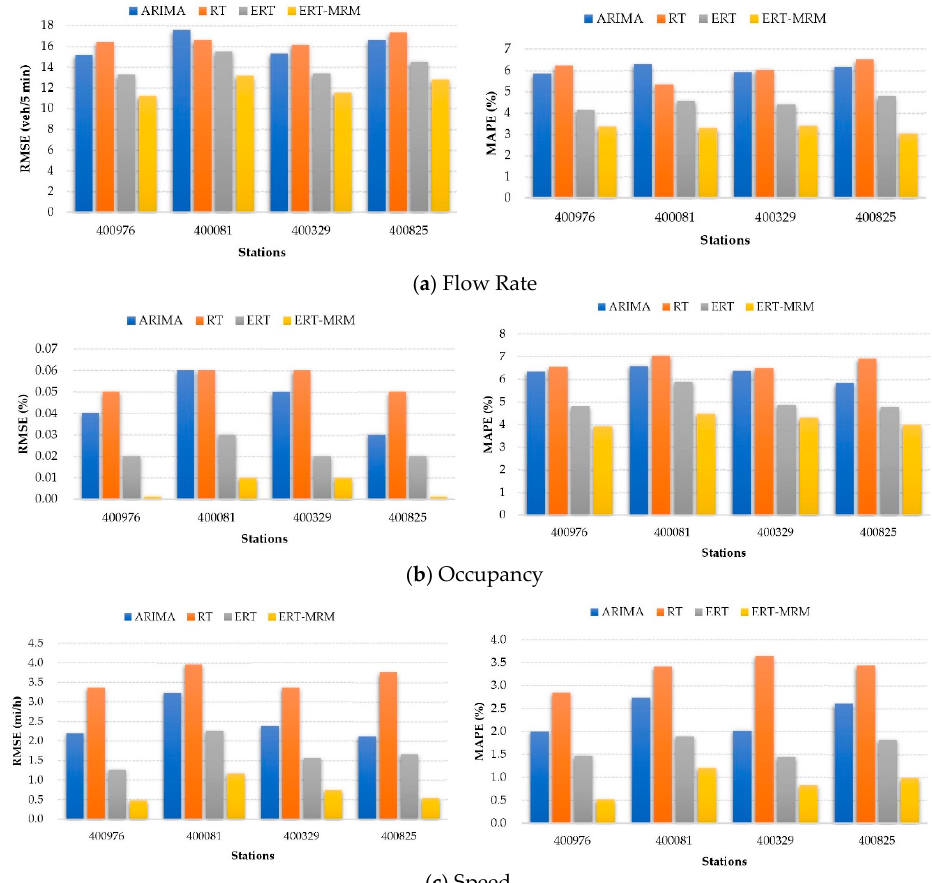
Figure 6. Performance of the comparative forecasting models associated with different stations.